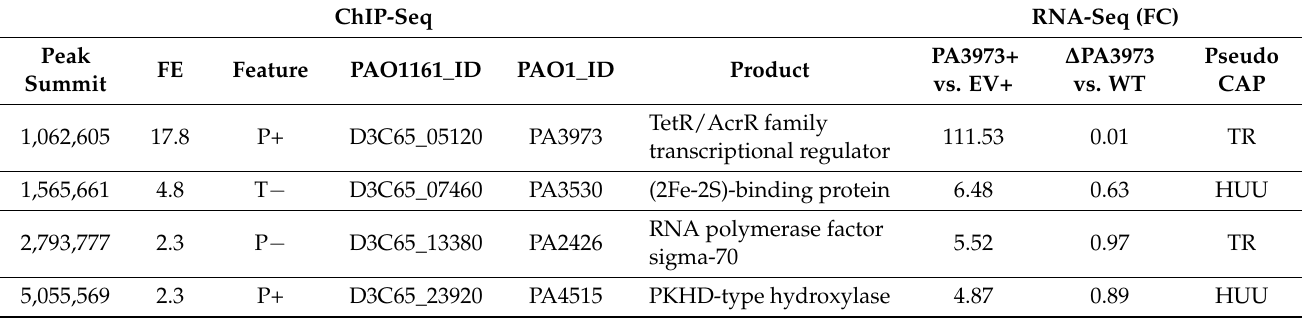
Table A2. List of 38 genes altered in response to PA3973 excess with PA3973 binding site in their promoter regions or adjacent to these genes. Full data for each peak/gene could be found in Tables S3–S6. Abbreviations: P-promoter; T-terminator; gb-gene body; +/ − strand in